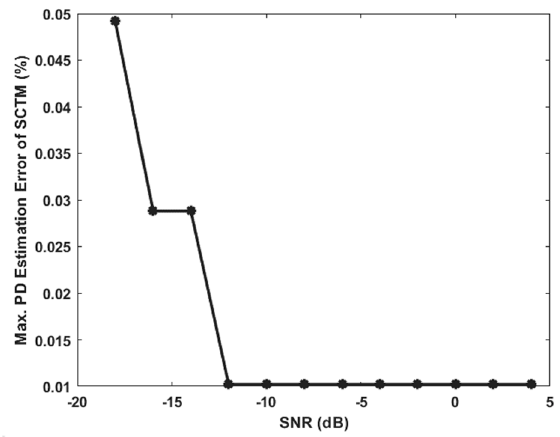
Figure 12. Maximum PD estimation error versus SNR for the SCTM algorithm.